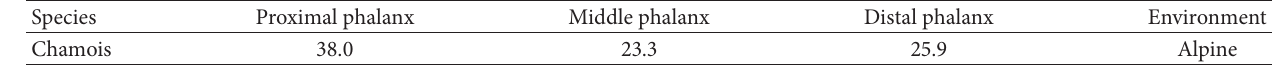
Table 1: Average length of osseous structures of the digit in chamois (unit: mm).